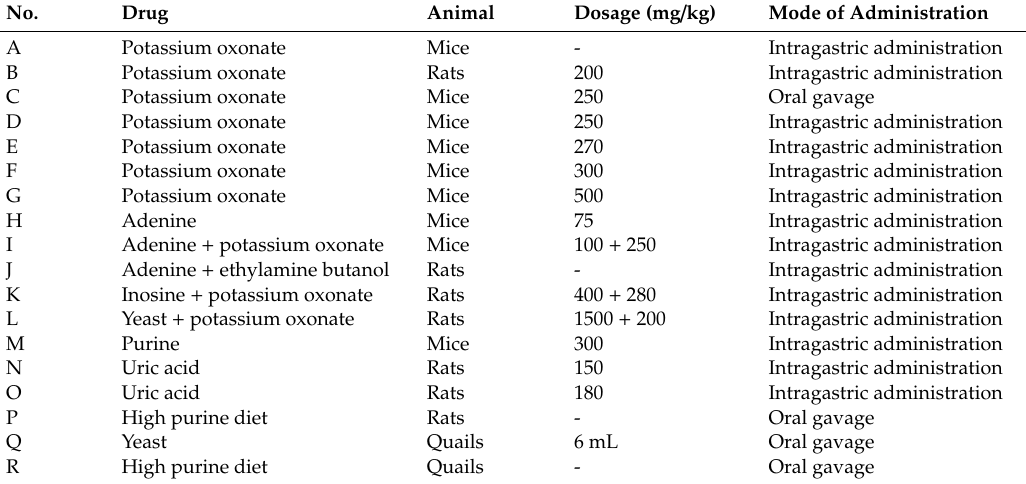
Table 1. Establishment of an animal model of Hyperuricemia (HUA) by